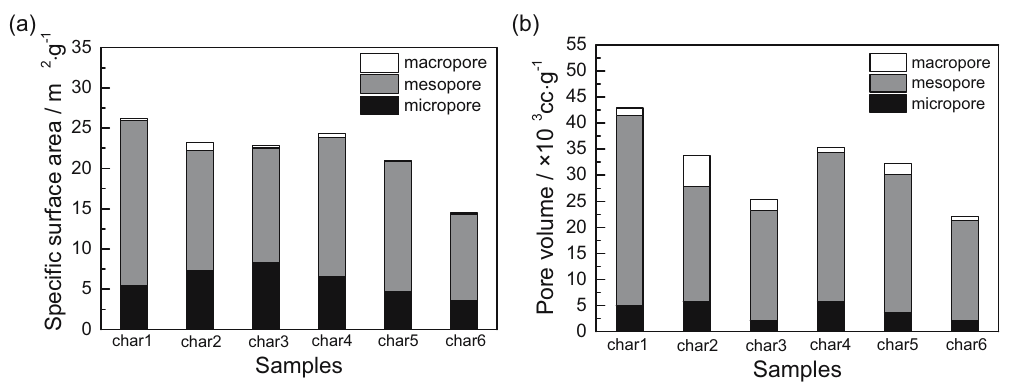
Figure 8: Speci fi c surface area and pore volume of semi - coke.